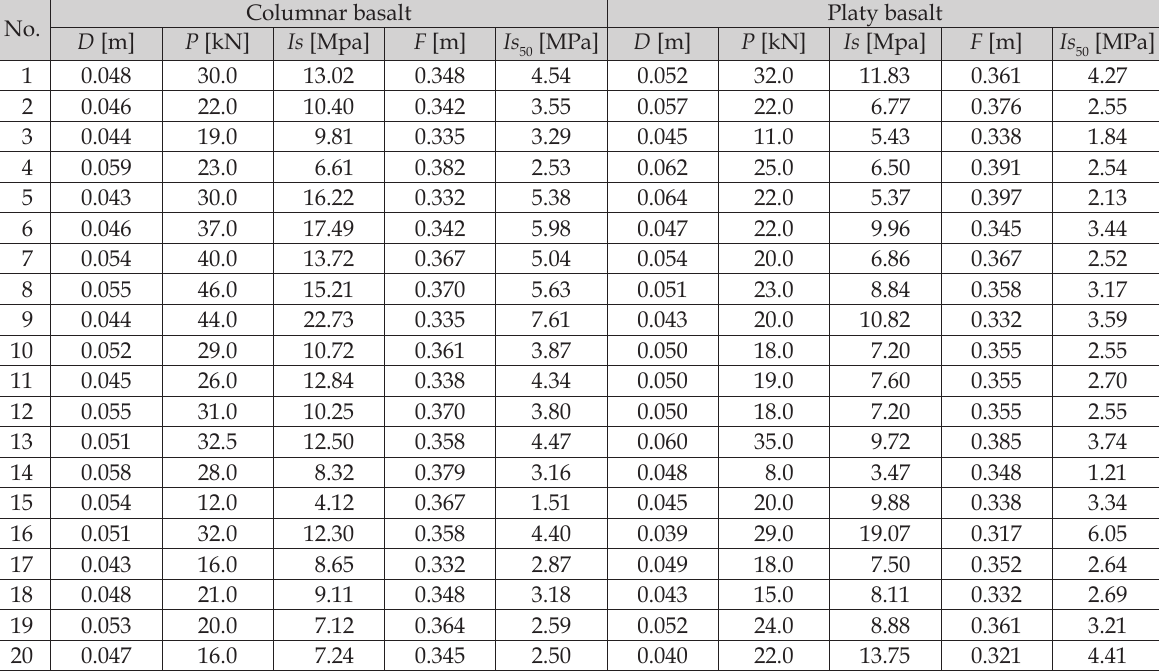
Fig. 6. Geological engineering data a – the average CS and b – the point load index of studied basalts. CS, compressive strength. Table 2. Geoengineering data presents diameter ( D ), load ( P ), point load index ( Is ), geometric correction factor ( F ), and impact strength ( Is 50